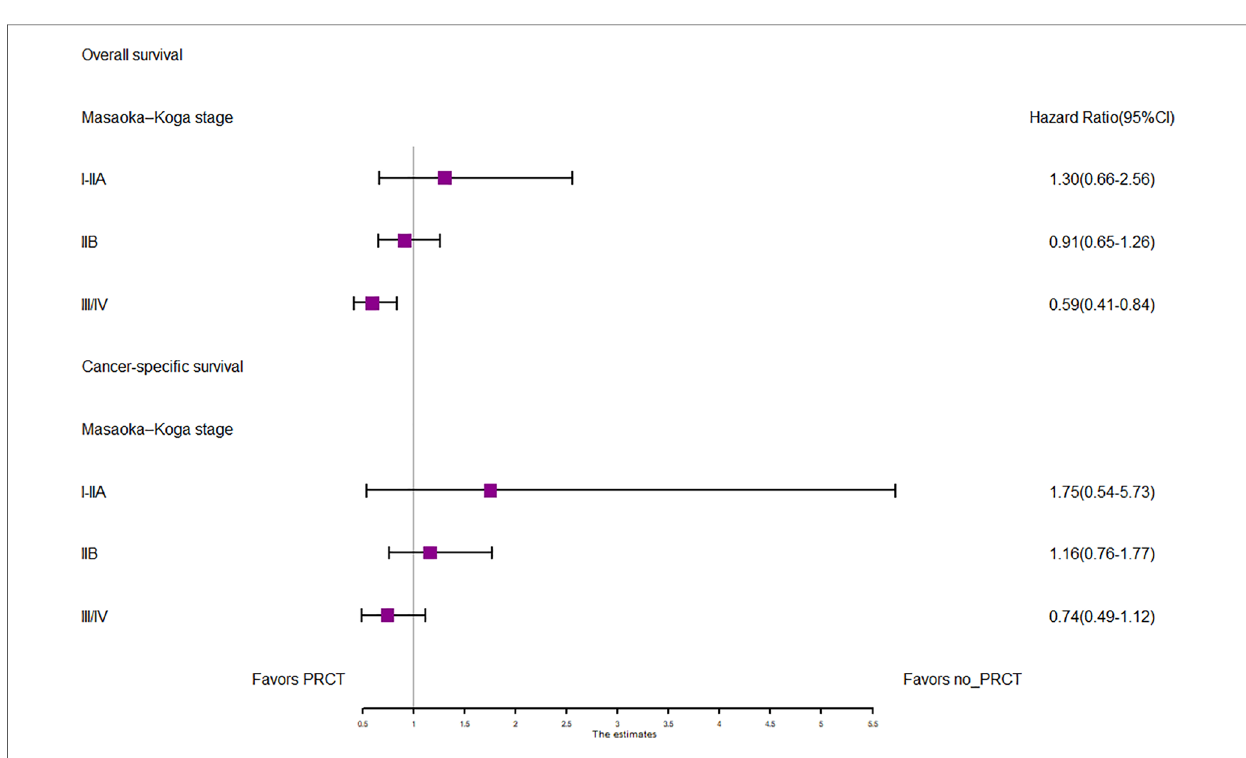
FIGURE 3 Survival curves of CSS in the POCT group and no-POCT group in patients undergoing surgery for TETs at different stages before propensity matching.